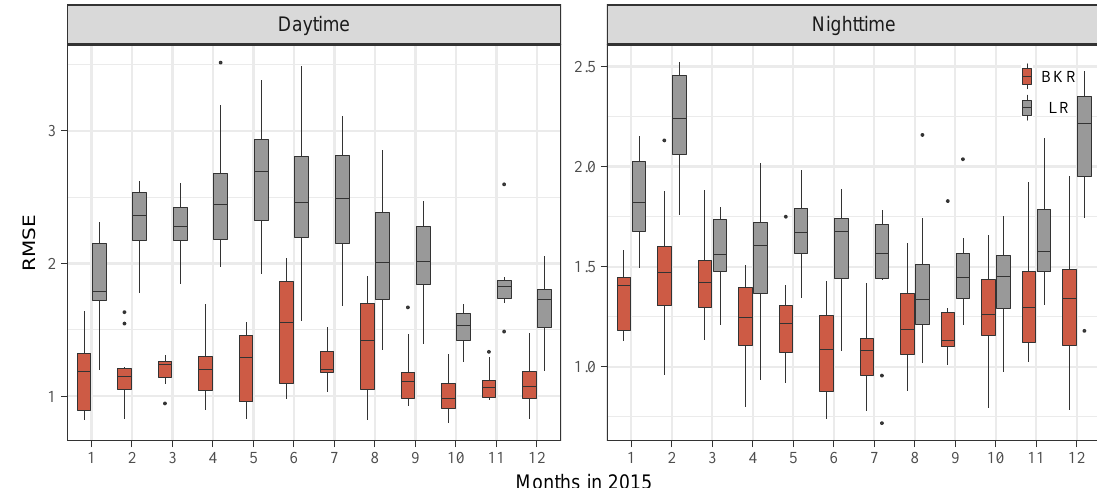
Figure 7. The urban areas scenario: boxplot of RMSEs of the LR and BKR for 12 months in 2015: ( left ) models in the daytime case (Tmax). ( right ) Models in the nighttime case (Tmin).